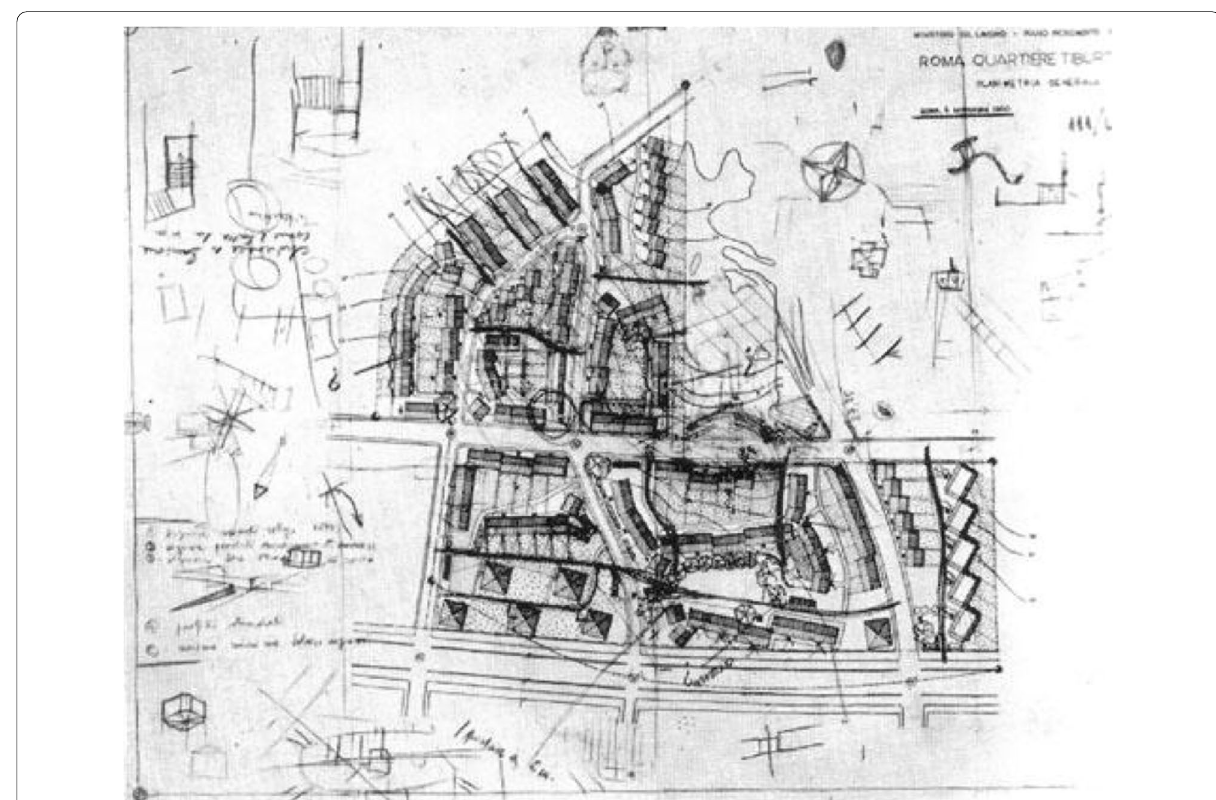
Fig. 12 Plan of the Tiburtino district, Rome, 1949–54. The main architects of the project were Ludovico Quaroni and Mario Ridolfi . Other architects who worked on this project were Carlo Aymonino, Mario Fiorentino, Federico Gorio, Maurizio Lanza, Piero Maria Lugli, Giulio Rinaldi, Michele Valori, Carlo Aymonino, Carlo Chiarini, Sergio Lenci, Carlo Melograni, Gian Carlo Menichetti and Volfango Frankl. Credits: Associazione archivio storico Olivetti, Fondo Quaroni Ludovico, Serie Progetti e corrispondenza, fasc.